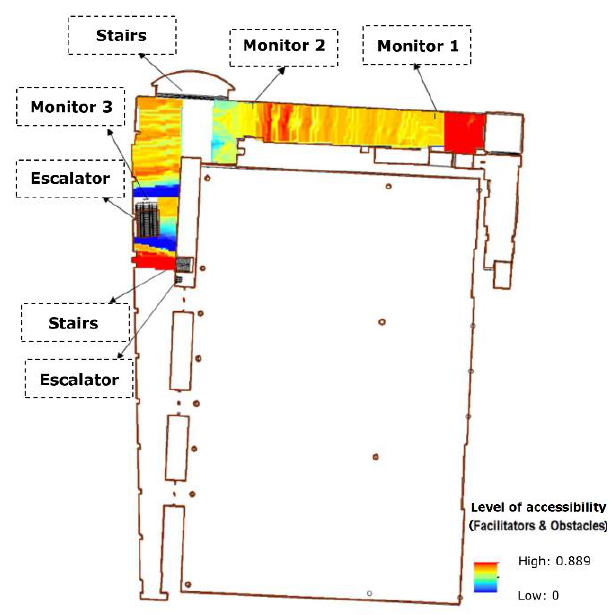
Figure 14. The level of accessibility for objects (facilitators / obstacles) .